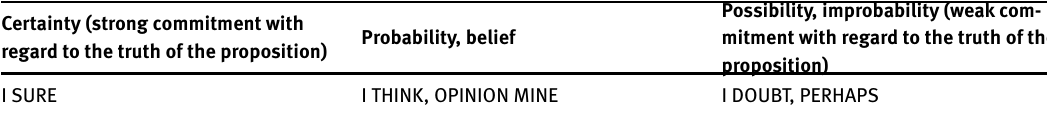
Table 2: subjective epistemic modality in LSE Certainty (strong commitment